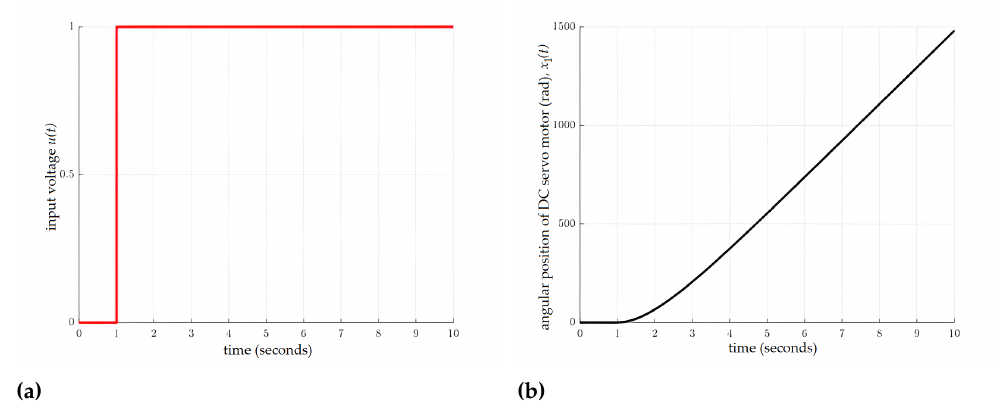
Figure 5. Input voltage ( a ) and open-loop step response for position ( b ) of the DC servo motor.